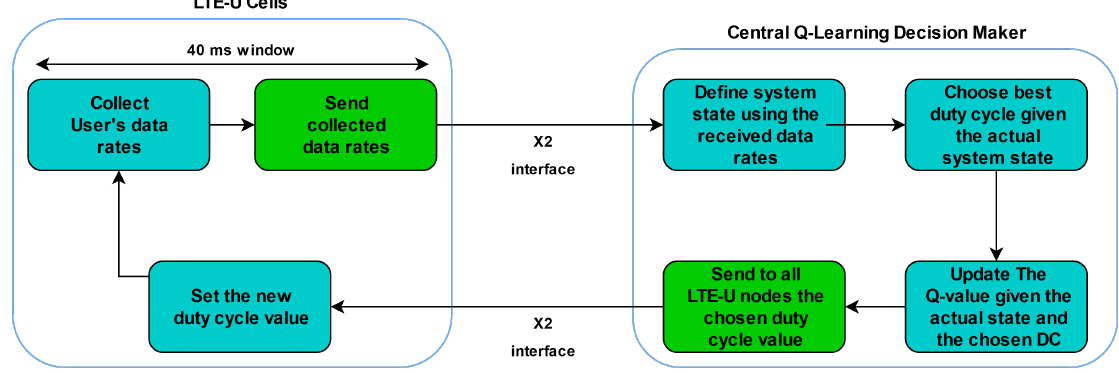
Figure 7. Proposed solution